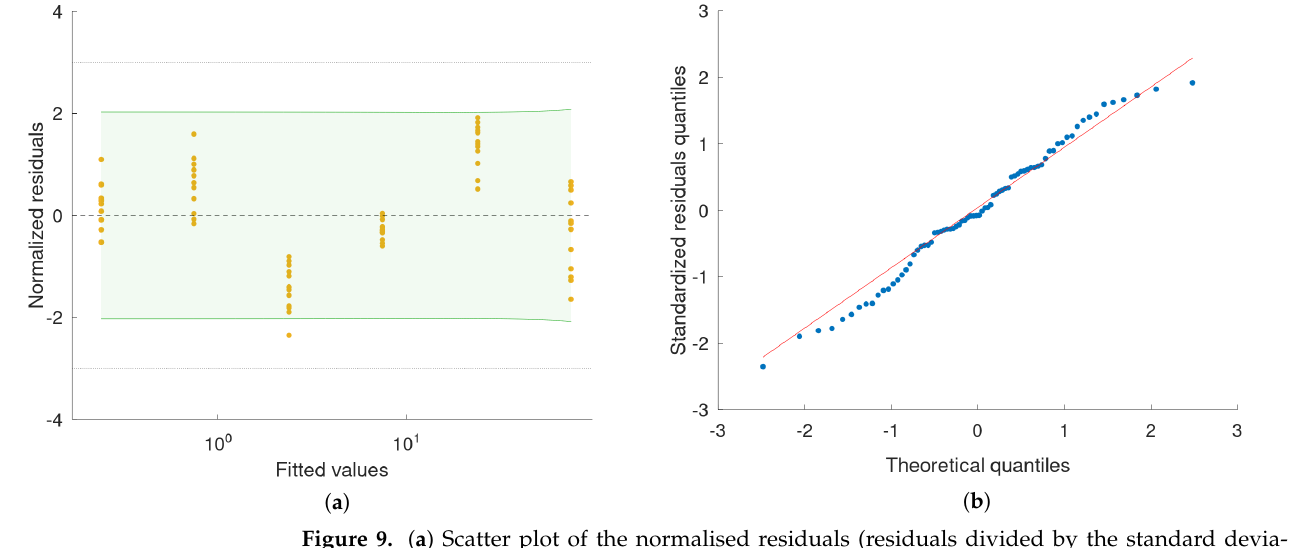
Figure 9. ( a ) Scatter plot of the normalised residuals (residuals divided by the standard devia- tion, σ = 6.6 nm) vs. fitted values from the linear regression model. Shapiro–Wilk test for normal- ity of residuals distribution: p = 0.50. Dashed lines indicate the ± 3 σ zone. The green–shaded area represents the 95% prediction interval for a new observation based on the obtained model. ( b ) Quantile–quantile plot of the estimated residuals’ distribution against the normal distribution.